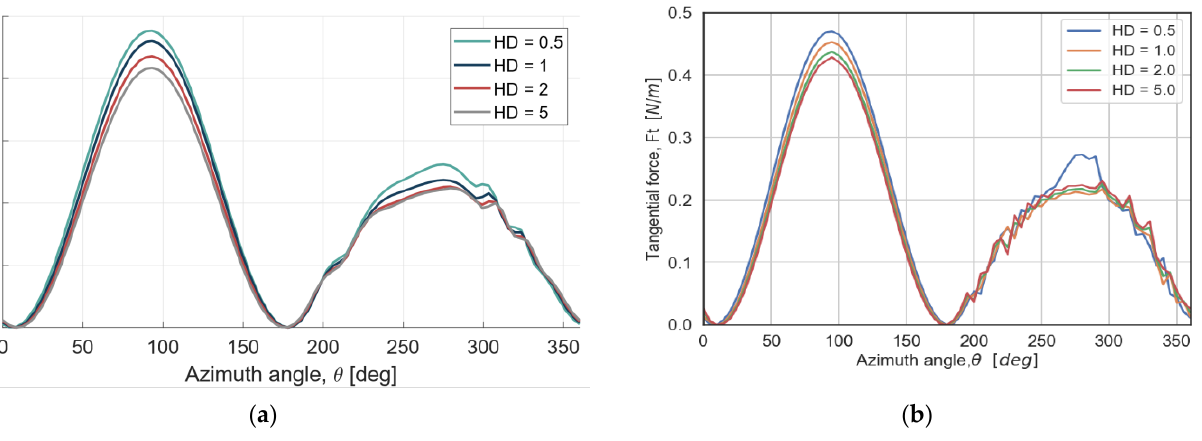
Figure 3. Tangential blade force with respect to the azimuth angle ( a ) CACTUS, fixed-wake [26]; ( b ) this study (QBlade).